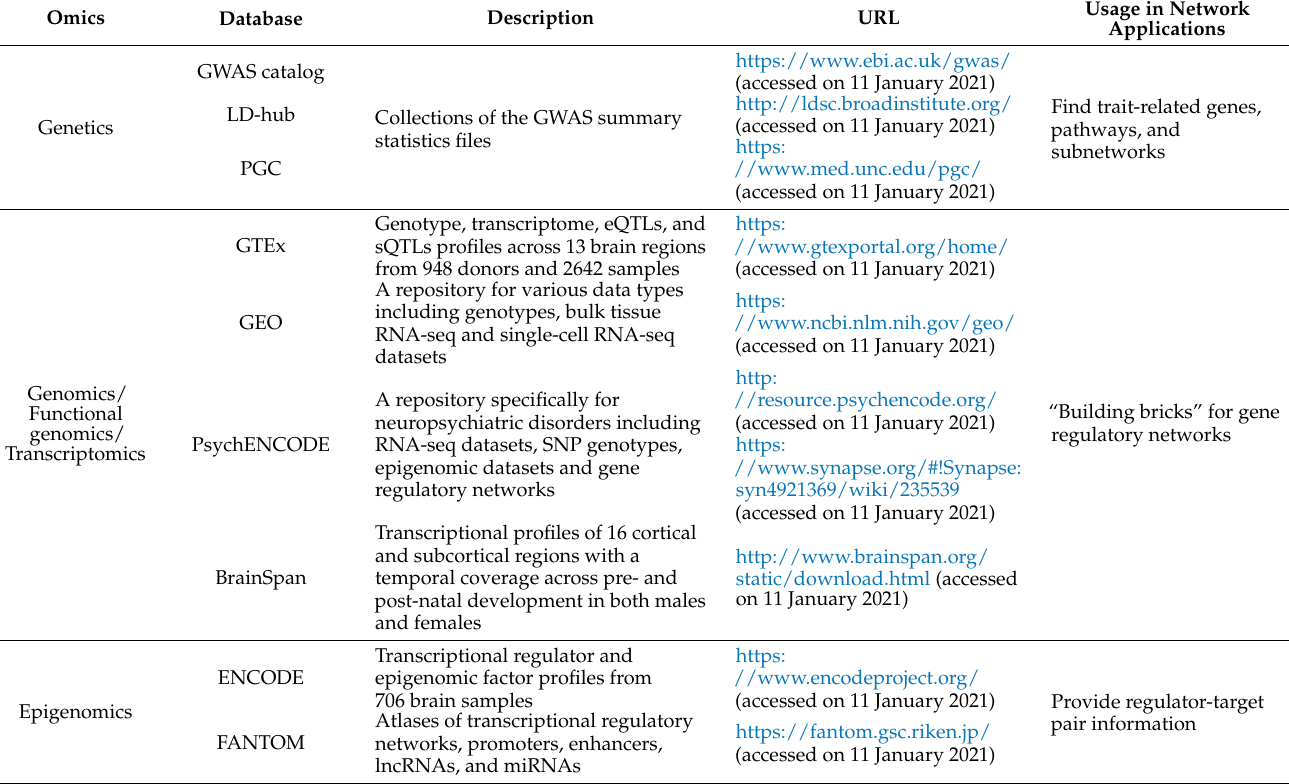
Table 1. Publicly available repositories of multi-tissue multi-omics data related to psychiatric research.